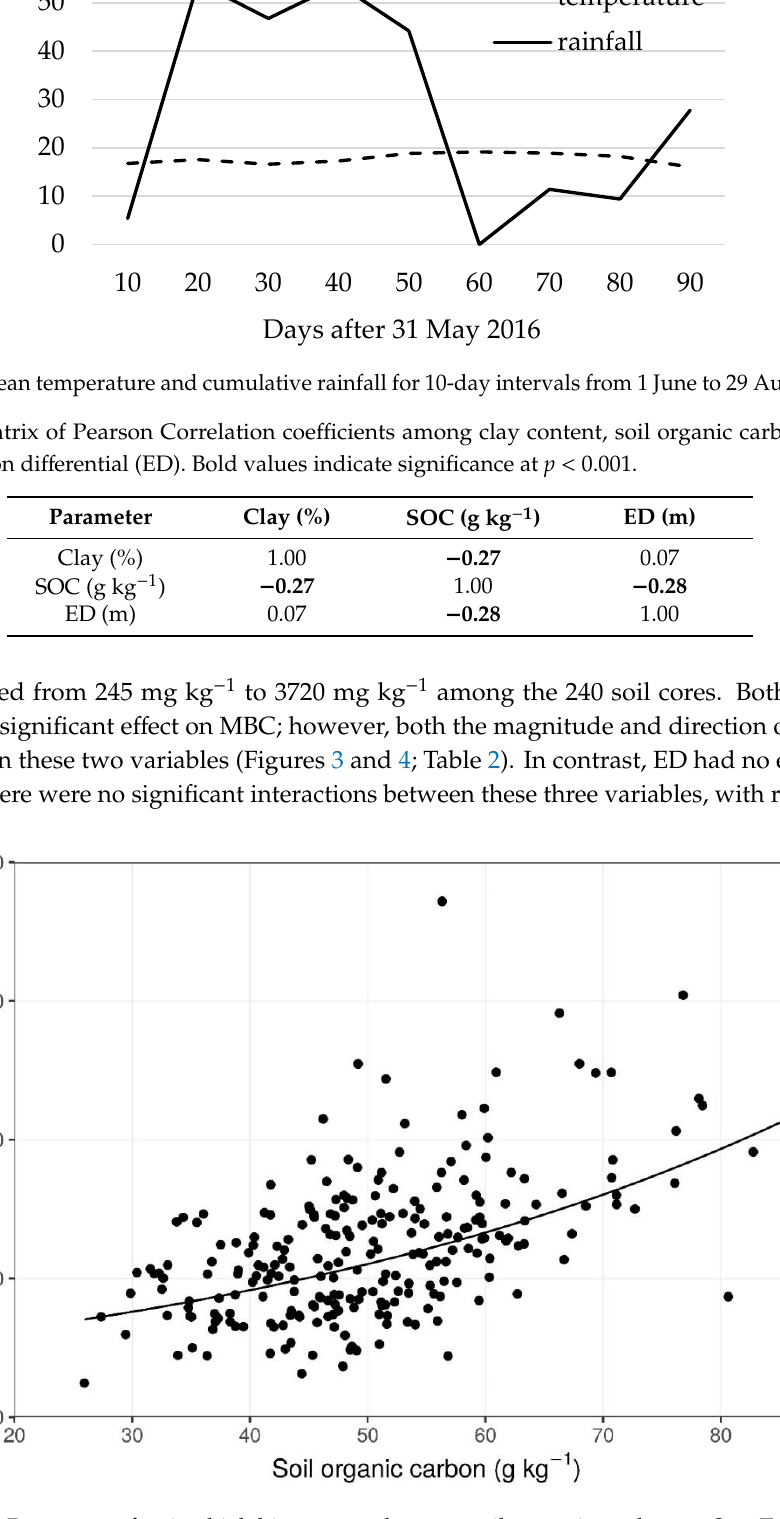
Figure 4. Response of microbial biomass carbon to clay content. See Table 2 for additional information.